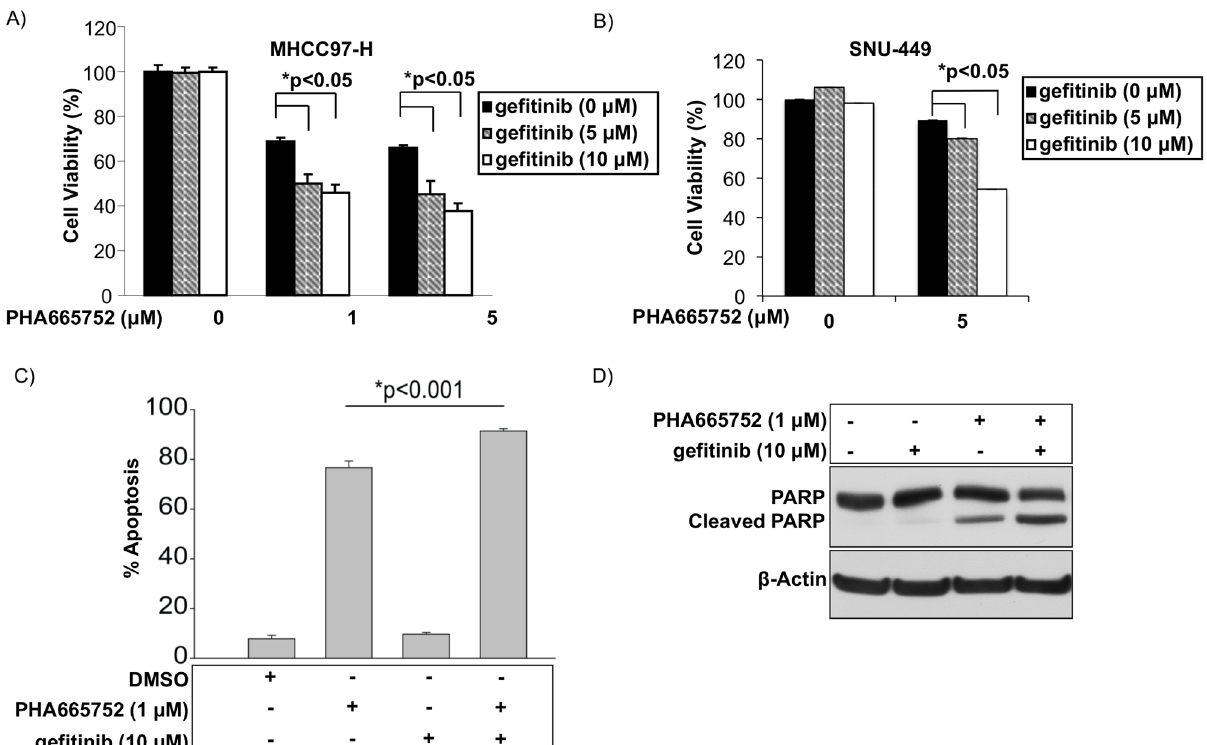
Fig 3. Combined inhibition of EGFR and c-Met in c-Met + HCC leads to superior suppression of tumor growth than c-Met inhibitor alone in c-Met + HCC. XTT cell viability assay 48 hours after treatment of A) MHCC97-H and B) SNU-449 cells treated with EGFR inhibitor gefitinib, c-Met inhibitor PHA665752 or both inhibitors. C) Apoptosis by flow cytometry of MHCC97-H cells treated with EGFR inhibitor gefitinib (10 μ M), c-Met inhibitor PHA665752 (1 μ M) or both. D) PARP cleavage by immunoblot 48 hours after treatment of MHCC97-H cells with EGFR inhibitor gefitinib (10 μ M), c-Met inhibitor PHA665752 (1 μ M) or both